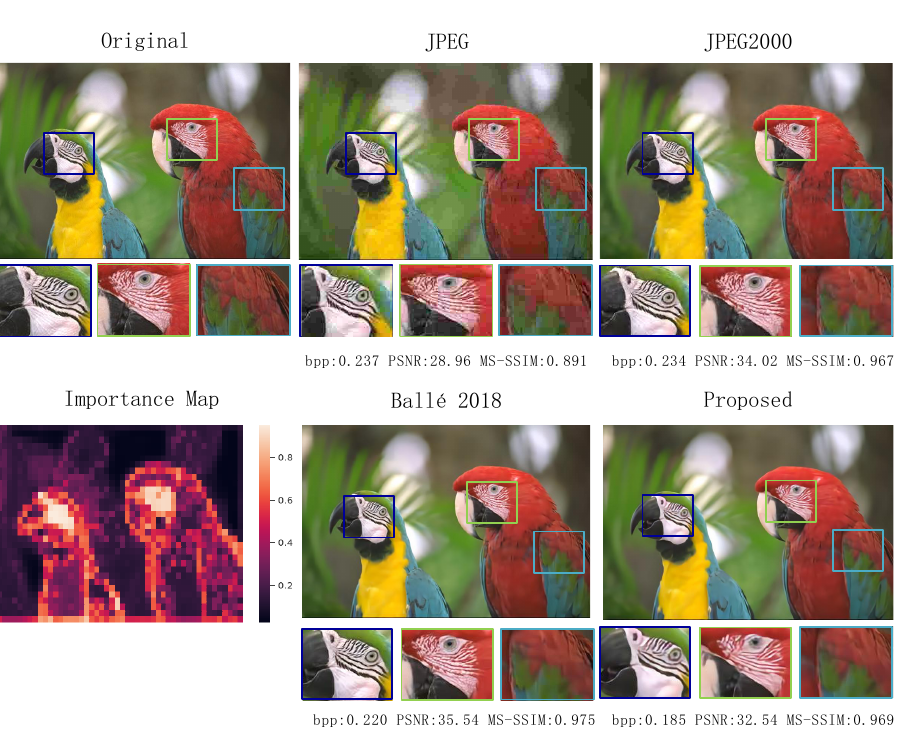
Figure 8. Visual quality evaluation of the specific image named kodim23 in Kodak dataset with different